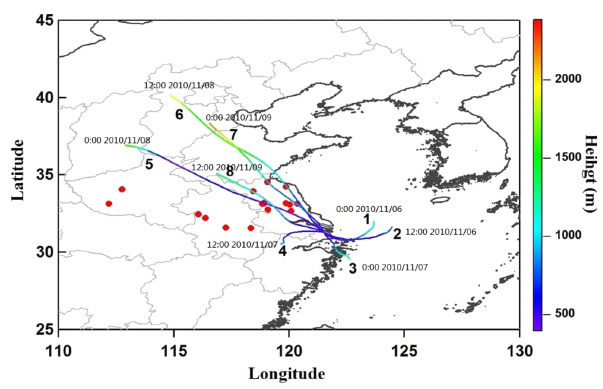
Figure 2. Temporal variations of temperature, wind speed and di- rection, RH, pressure and atmospheric visibility, the foggy–hazy case is marked in red open boxes and the hazy case in